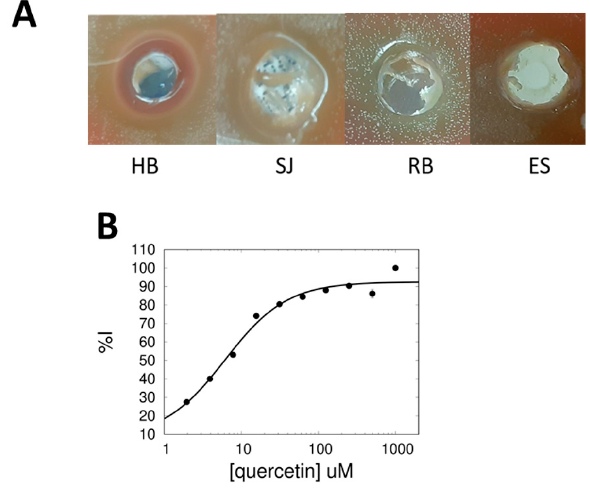
Figure 1. ( A ) Growth inhibition profiles from plate assays with hibiscus (HB), Saint John’s wort (SJ), Rooibis (RB) and Espinheira Santa (ES). ( B ) Dose–response assay of sChoK inhibition with quercetin.